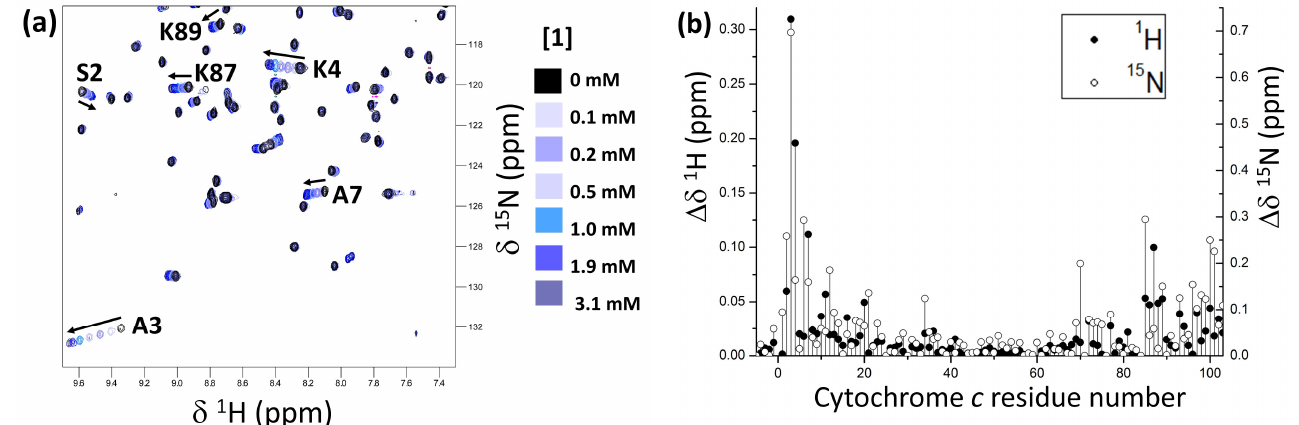
Figure 2. ( a ) Overlaid 1 H– 15 N HSQC spectral region of 0.1 mM cytochrome c in the absence (black contours) or in the presence of 0.1–3.1 mM 1 (blue scale). ( b ) Chemical shift perturbation plots of cytochrome c amides at ∽ 30 eq. compound 1 . Cytochrome c residues are numbered from –5 to 103. Blanks correspond to proline residues 25, 30, 71, and 76, and unassigned G84. These observations are consistent with a preference for lysine binding, as